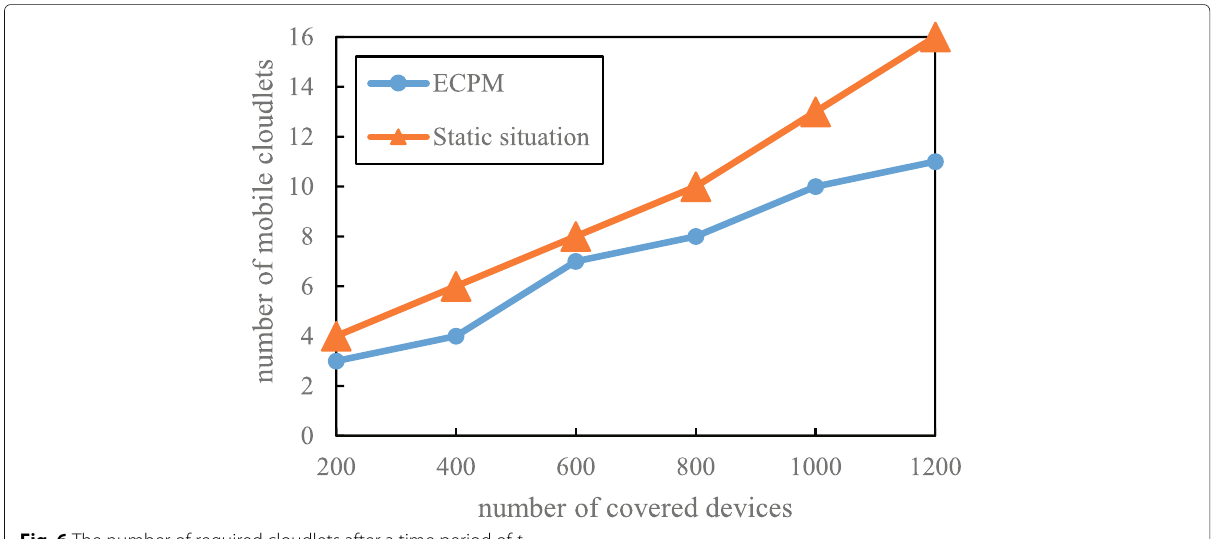
Fig. 6 The number of required cloudlets after a time period of t